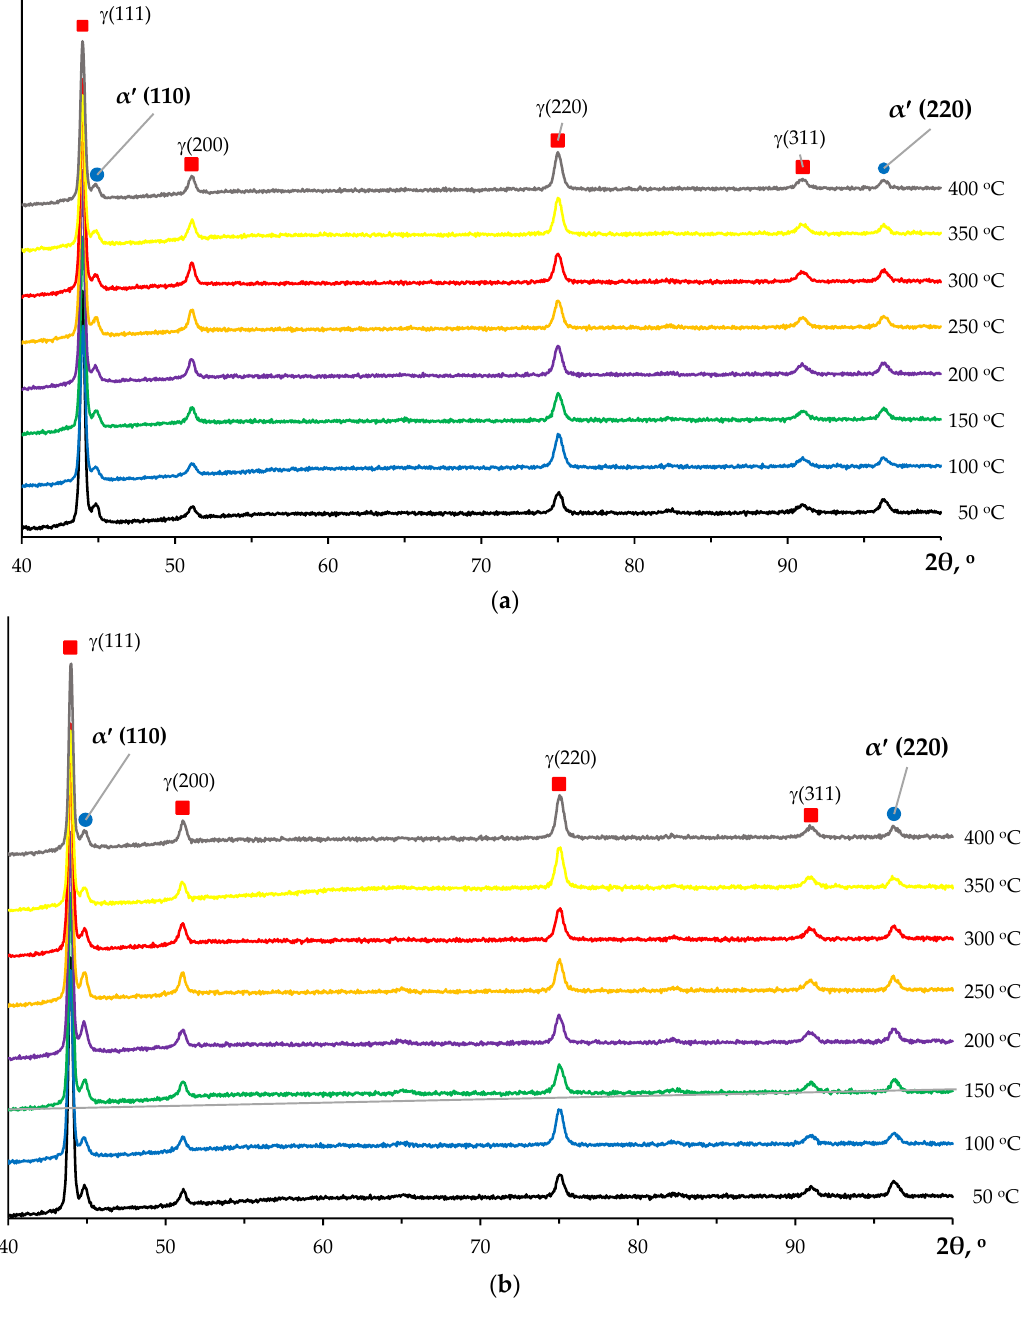
Figure B2. XRD curves for specimens cut out from transverse ( a ) and longitudinal ( b ) sections of workpieces obtained by ECAP at different temperatures.